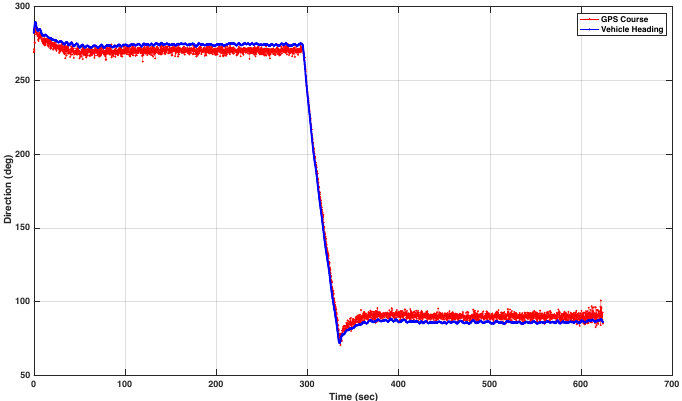
Figure 22. Heading and Course of the Medusa Vehicle Showing the effect of ocean currents.